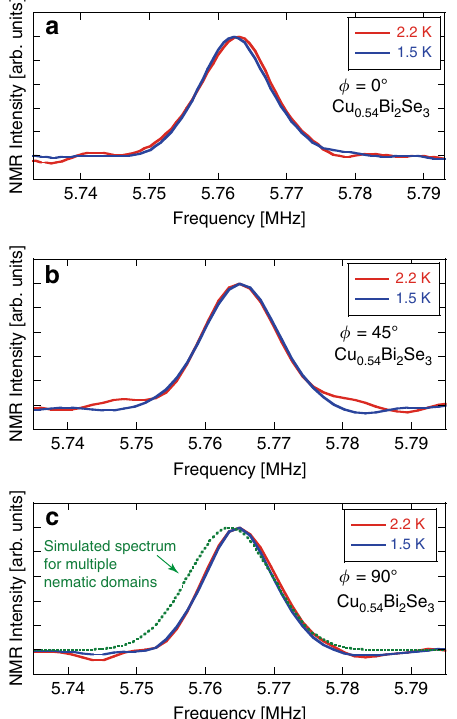
Fig. 9 NMR spectra and simulation. NMR spectra at T c ( H = 0.7 T) = 2.2 K and below for x = 0.54 with different angles between H and the a -axis ( a – c ). c A simulation for the spectrum in presence of multiple nematic domains, simply assuming that various domains are distributed